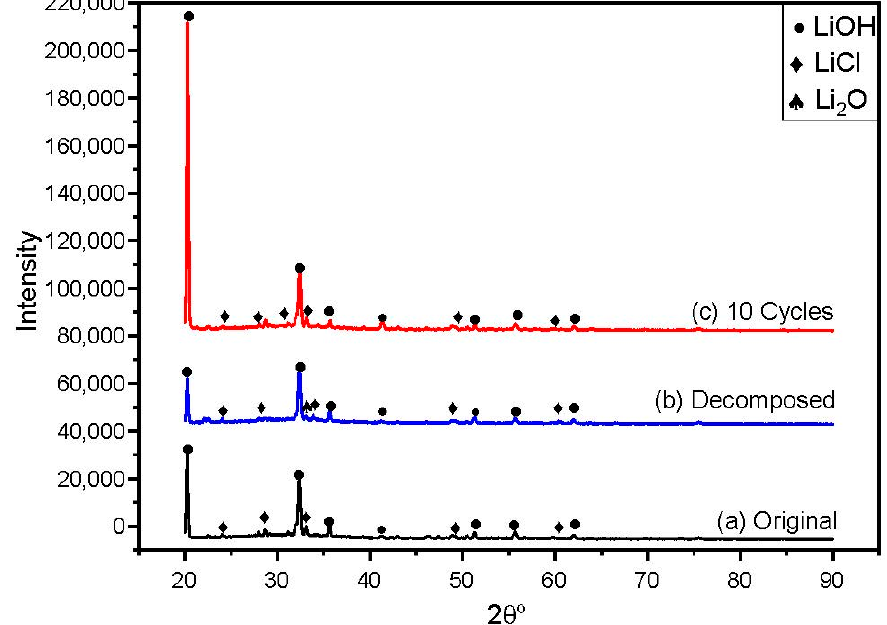
Figure 8. XRD patterns of the chosen salt composition (32 mol% LiCl-68 mol% LiOH) at different conditions ( a ) as prepared, ( b ) heated at 700 ◦ C, and ( c ) cooled for 10